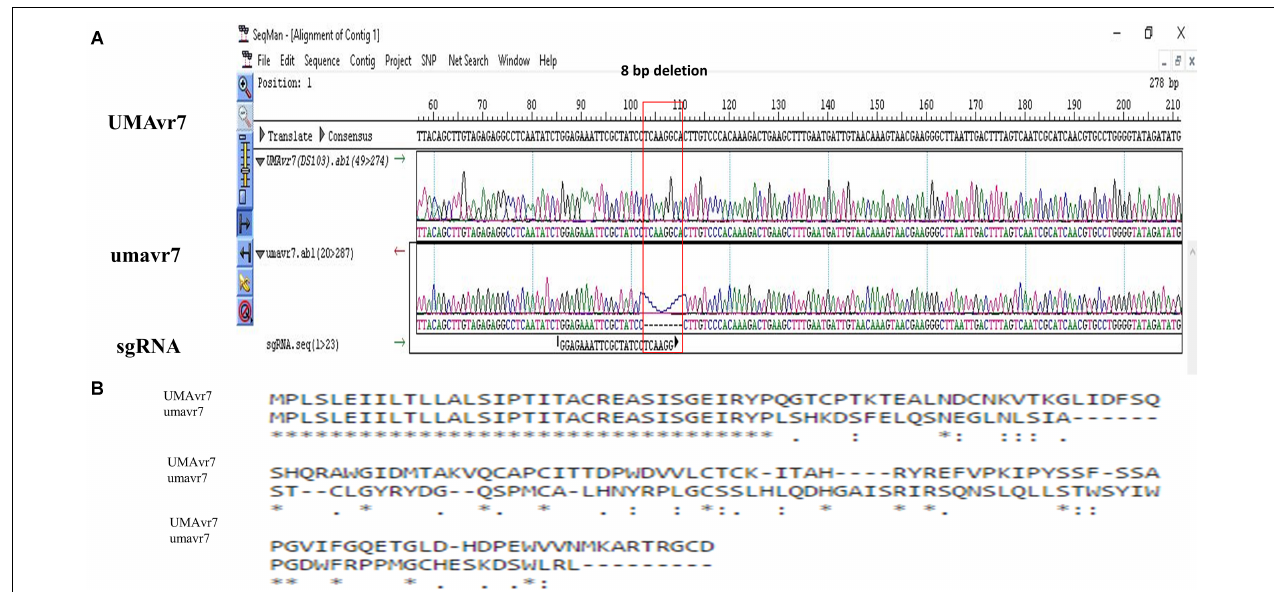
FIGURE 3 | CRISPR/Cas9 mediated gene editing of AvrLm4-7 gene of Leptosphaeria maculans . (A) The mutant isolate umavr7 carries an 8 bp deletion overlapping targeted sgRNA region. (B) Alignment of deduced amino acid sequences of AvrLm4-7 with wild type isolate UMAvr7 and mutant isolate umavr7. Amino acid residues with asterisks are conserved in aligned